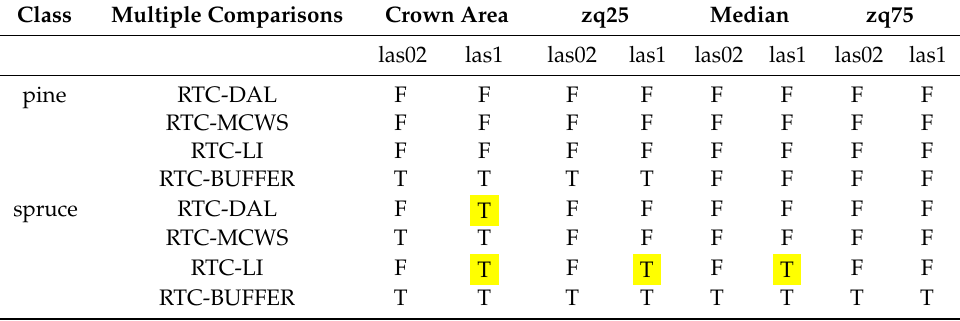
Table 12. The treatment versus control multiple comparison test after the Kruskal–Wallis test of elevation features. True (T) or False (F) marks statistically significant / insignificant di ff erences between pairs. Significant di ff erences among las02 and las1 within treatment versus control tests caused by significantly lower segmentation accuracy of las1 are highlighted in